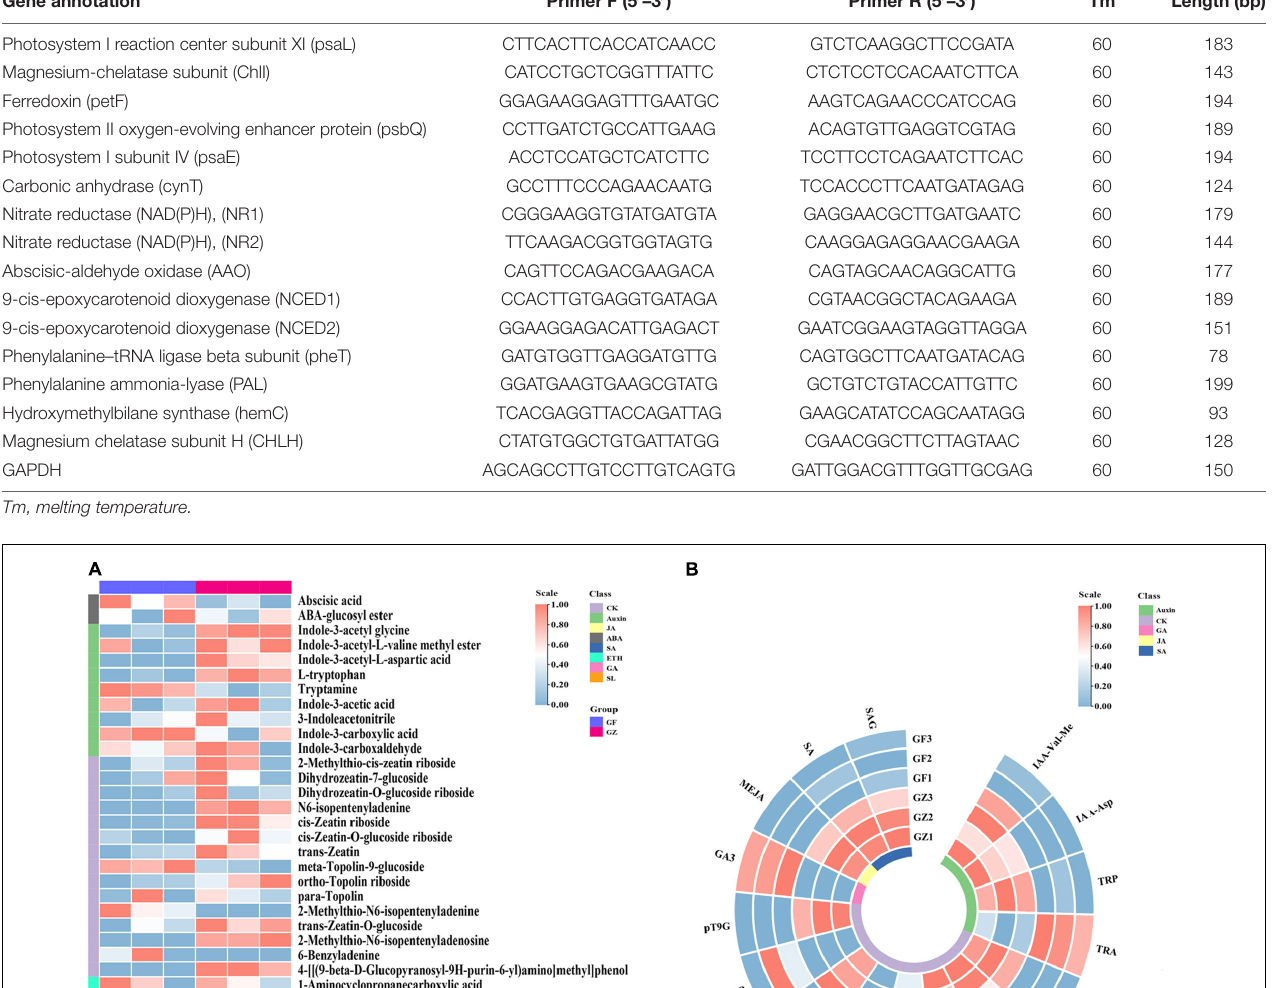
TABLE 1 | Primers sequences used for quantitative real-time PCR analysis (qRT-PCR) for detecting gene expression. Gene